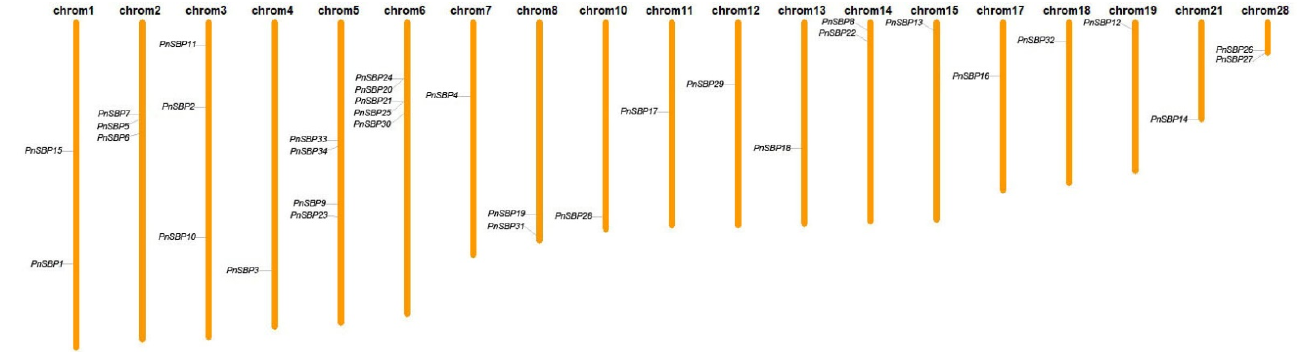
Figure 3. The conserved motifs in pepper SBP genes. The genes in the same group were drawn together, and the group number was marked to the left.